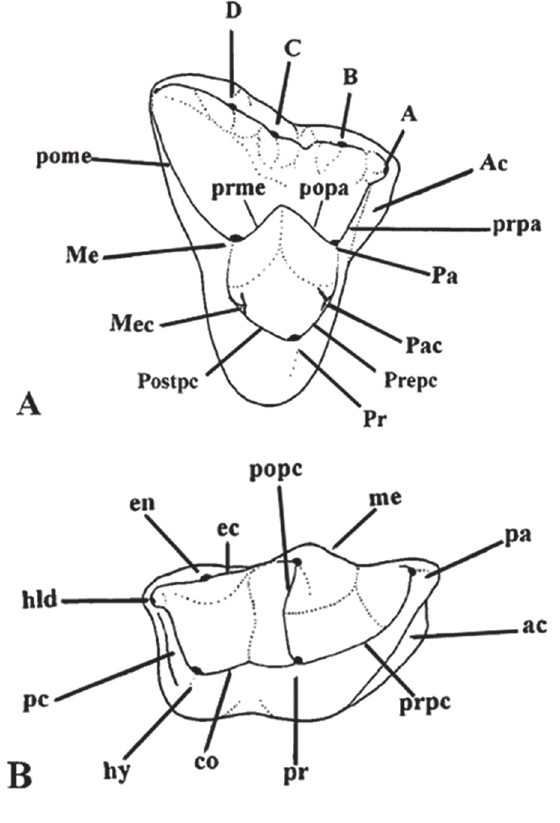
Figure 1 - Nomenclature for didelphimorph molar (modified from Goin and Candela 2004). A. Upper right molar; B. Lower right molar. Abbreviations for upper molars: A,